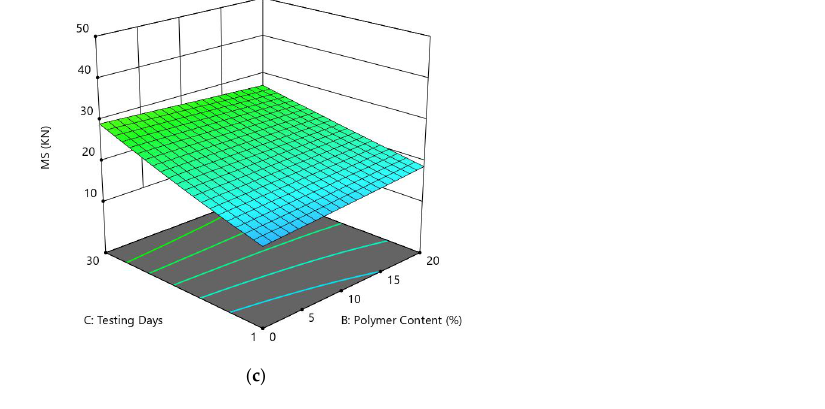
Figure 11. 3D response surface plots for the MS (kN) vs. ( a ) AB, ( b ) AC, ( c ) BC